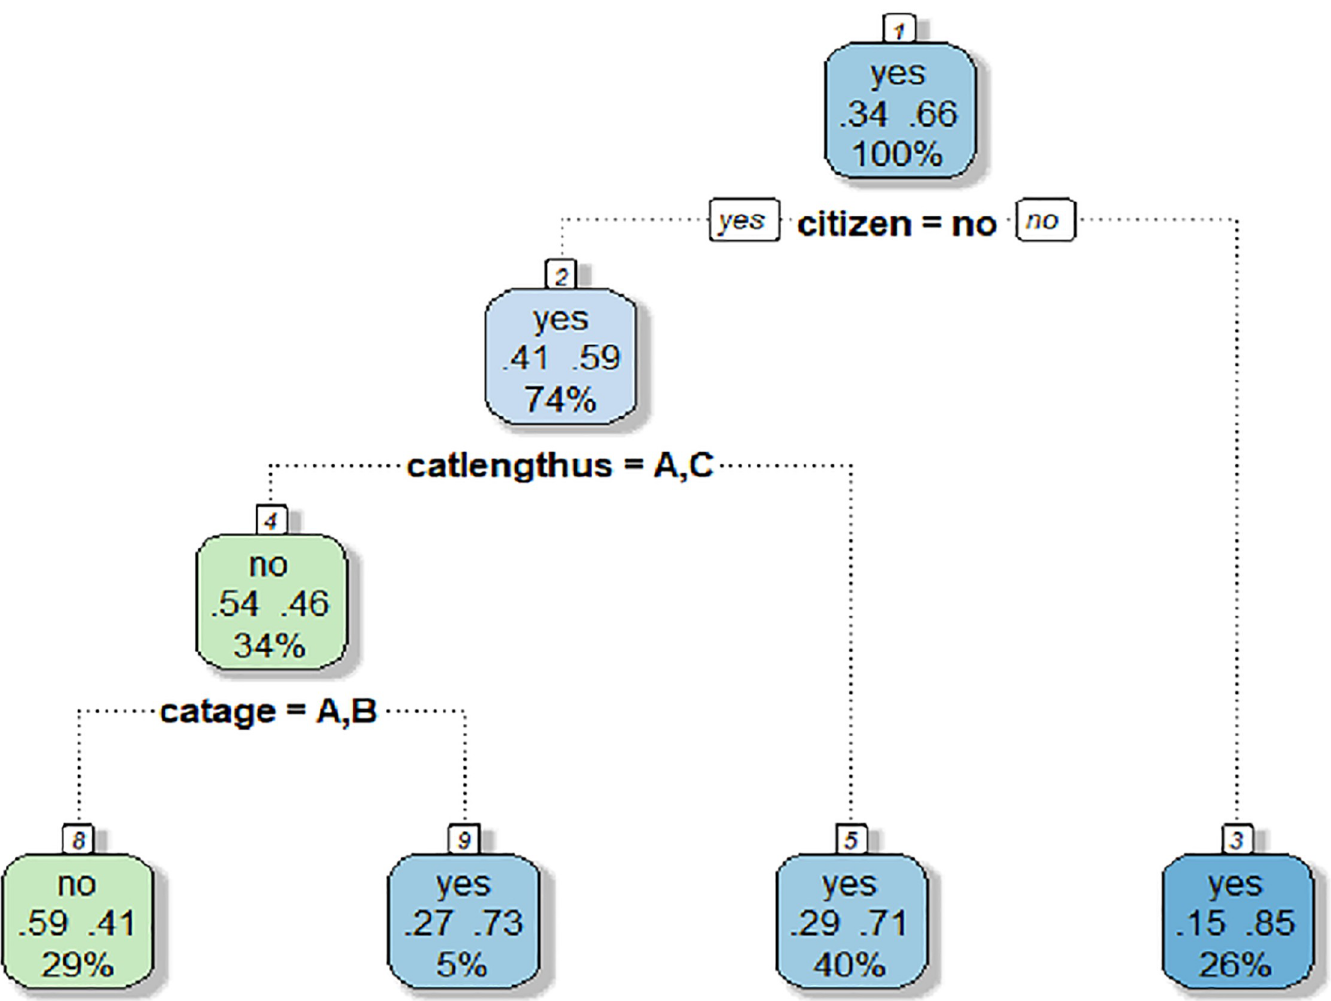
Fig 3. Decision tree–CART model, fancy rpart plot. There are numeric and text outputs associated with respective splits to aid in result interpretation. The figure featured at the top represents the predicted value per split. The number featured at the lower left represents the likelihood of the predicted split value. The number featured at the lower right represents the likelihood of the opposite endorsement value. The percentage at the bottom represents the size of the sample passing through the node per split. For example, with node number 2, the group is inclined to take on the activity, “yes” regarding screening history. The probability for people to say “yes” in this group is .41 while the probability for the group to take on the opposite activity, “no,” is .59. Of the 346 study subjects, 74% of the data passed through this node. Overall, the decision tree selected citizenship, length of time in the U.S., and age as important predictors in ascertaining a women’s screening history. For example, with node 1, the model asks if the participant is not a citizen. If the participant responds affirmatively, she is not a citizen, she will be classified into the node on the left. If the participant responds in opposition, “no” they are indeed as citizen, she will be classified in the node on the